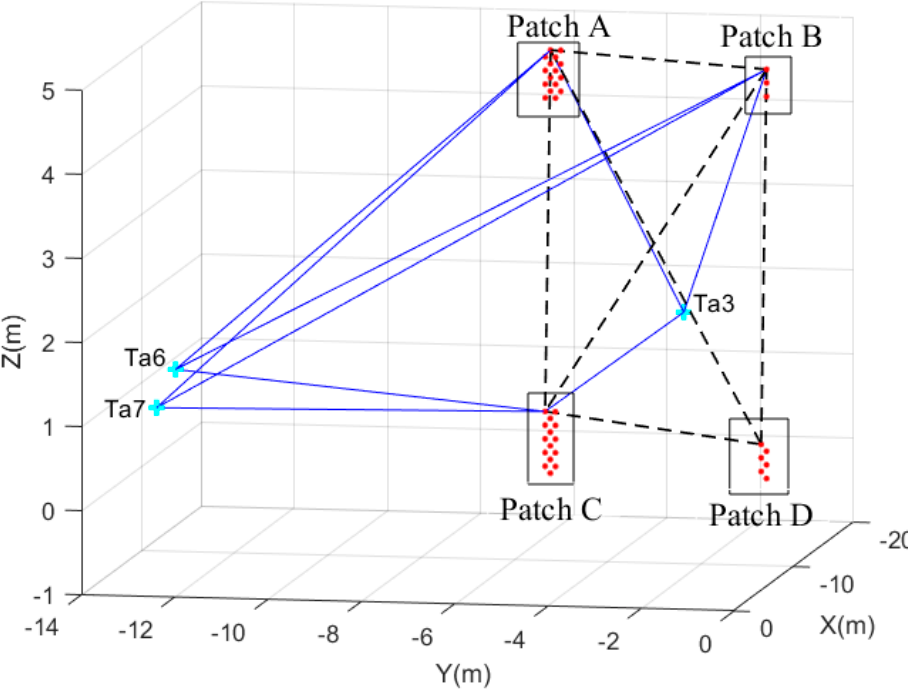
Figure 13. Baselines from virtual points to target points are indicated by continuous lines, while baselines connecting virtual points are shown as dashed lines.